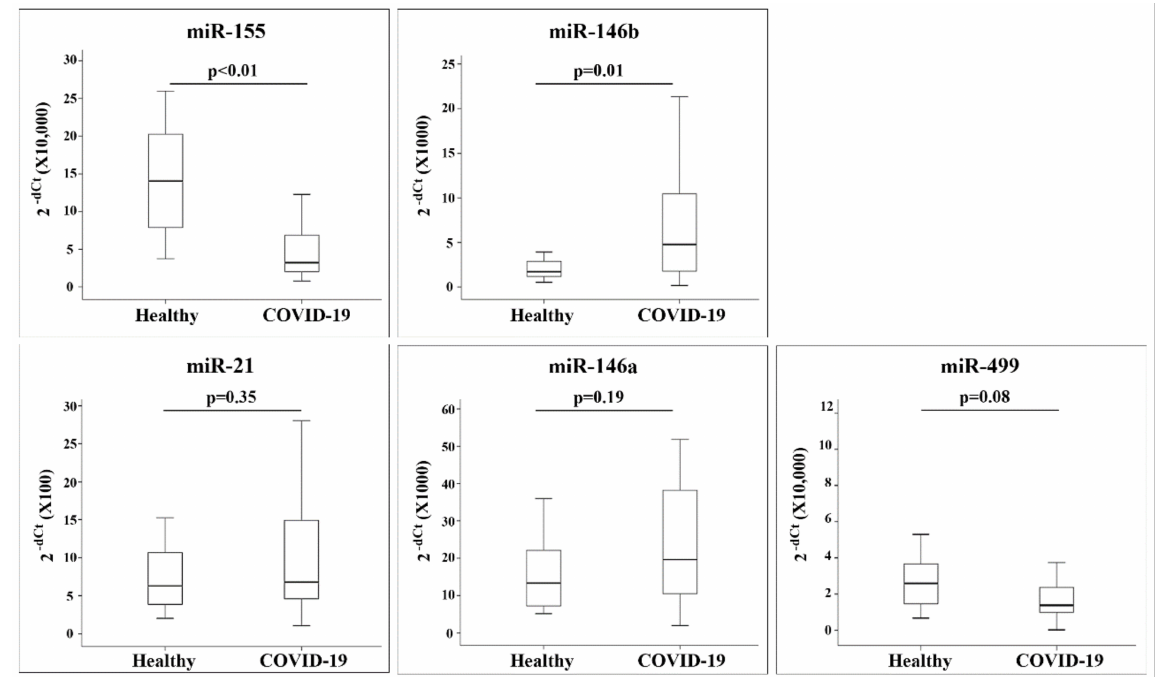
Figure 1. MiRNA expression in healthy and COVID-19 patients: 2 − dCt values quantified by quan- titative RT-PCR (qRT-PCR) are presented as box plots showing the 10th, 25th, 50th, 75th, and 90th percentile of the